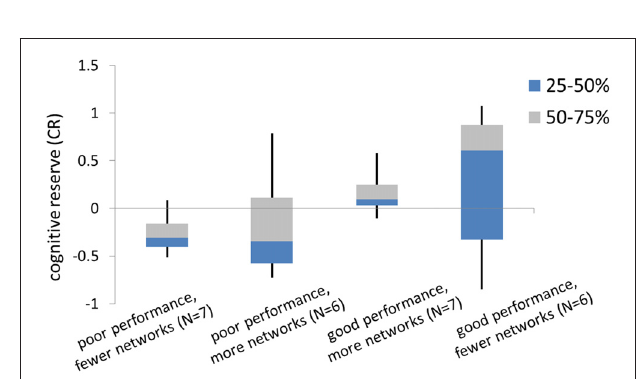
FIGURE 4 | The box diagram of cognitive reserve (CR) in subgroups. Subgroups were split by the median number of the memory performance (recall accuracy) during the fMRI task, and the median number of the compensatory